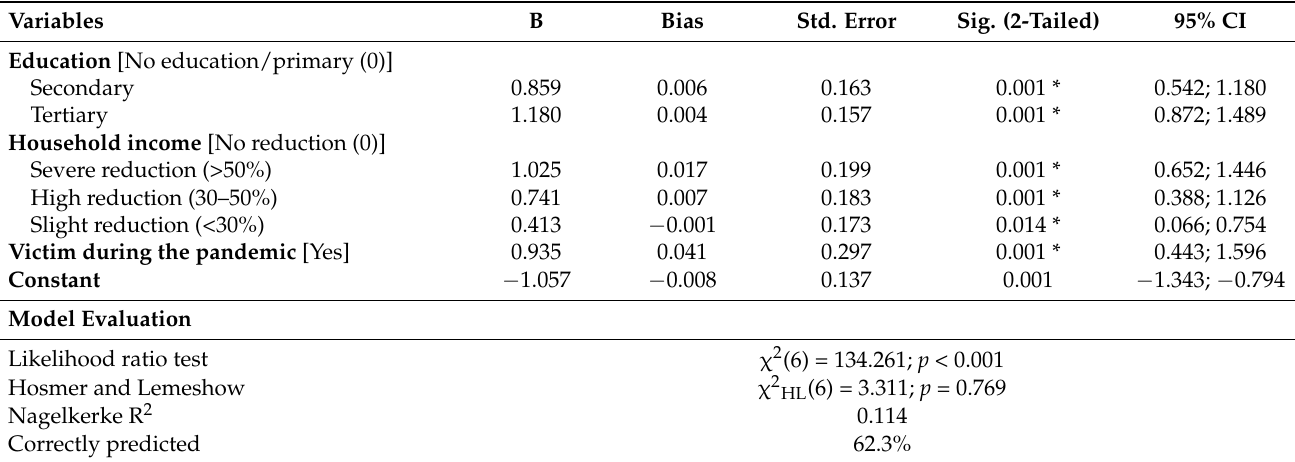
Table 5. Model 4—Mediation model for predicting the lockdown social impacts on women’s